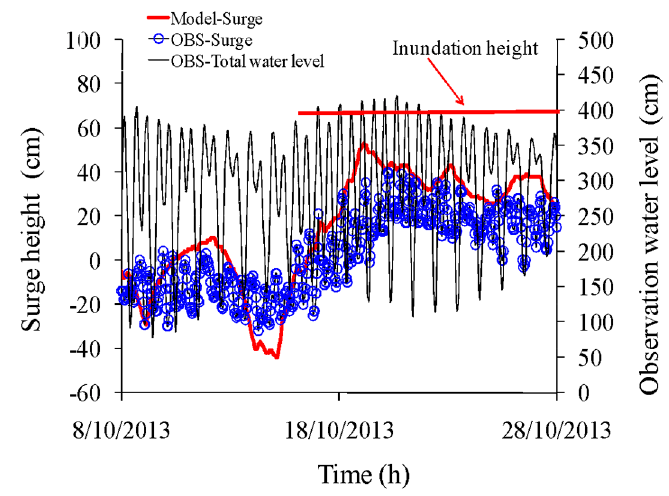
Figure 16. Comparison between numerical and observed surge heights at Vung Tau station during 16–28 October 2013.